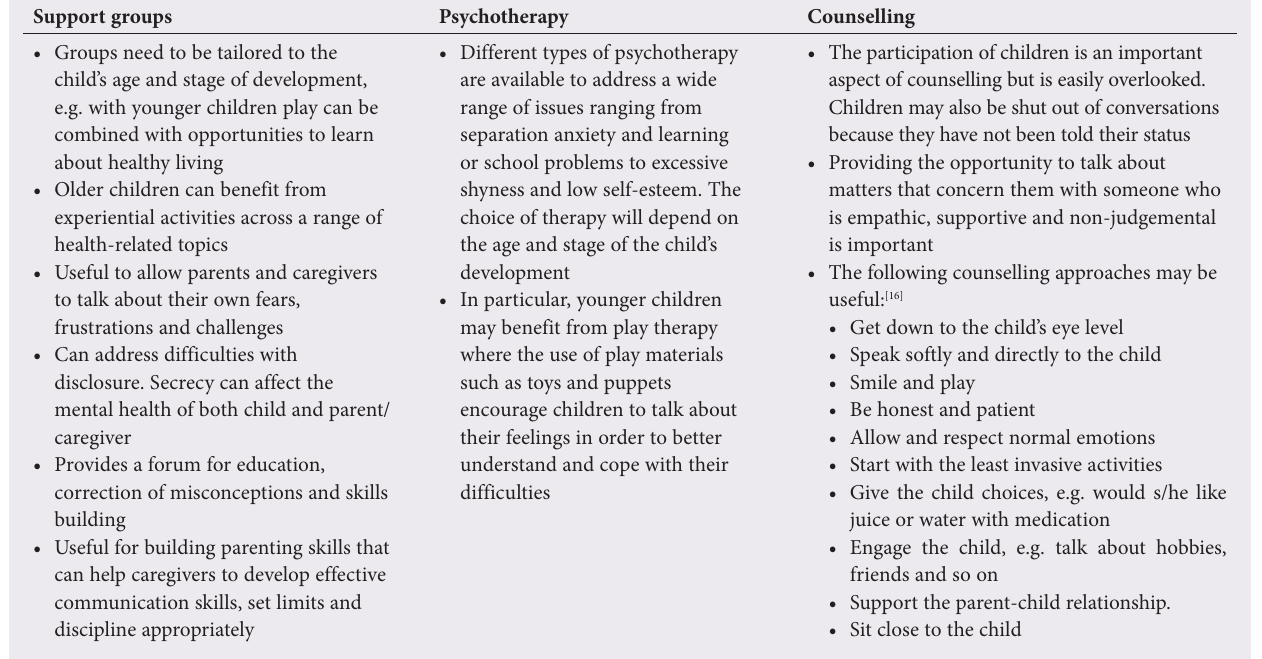
Table 12. Psychosocial interventions for